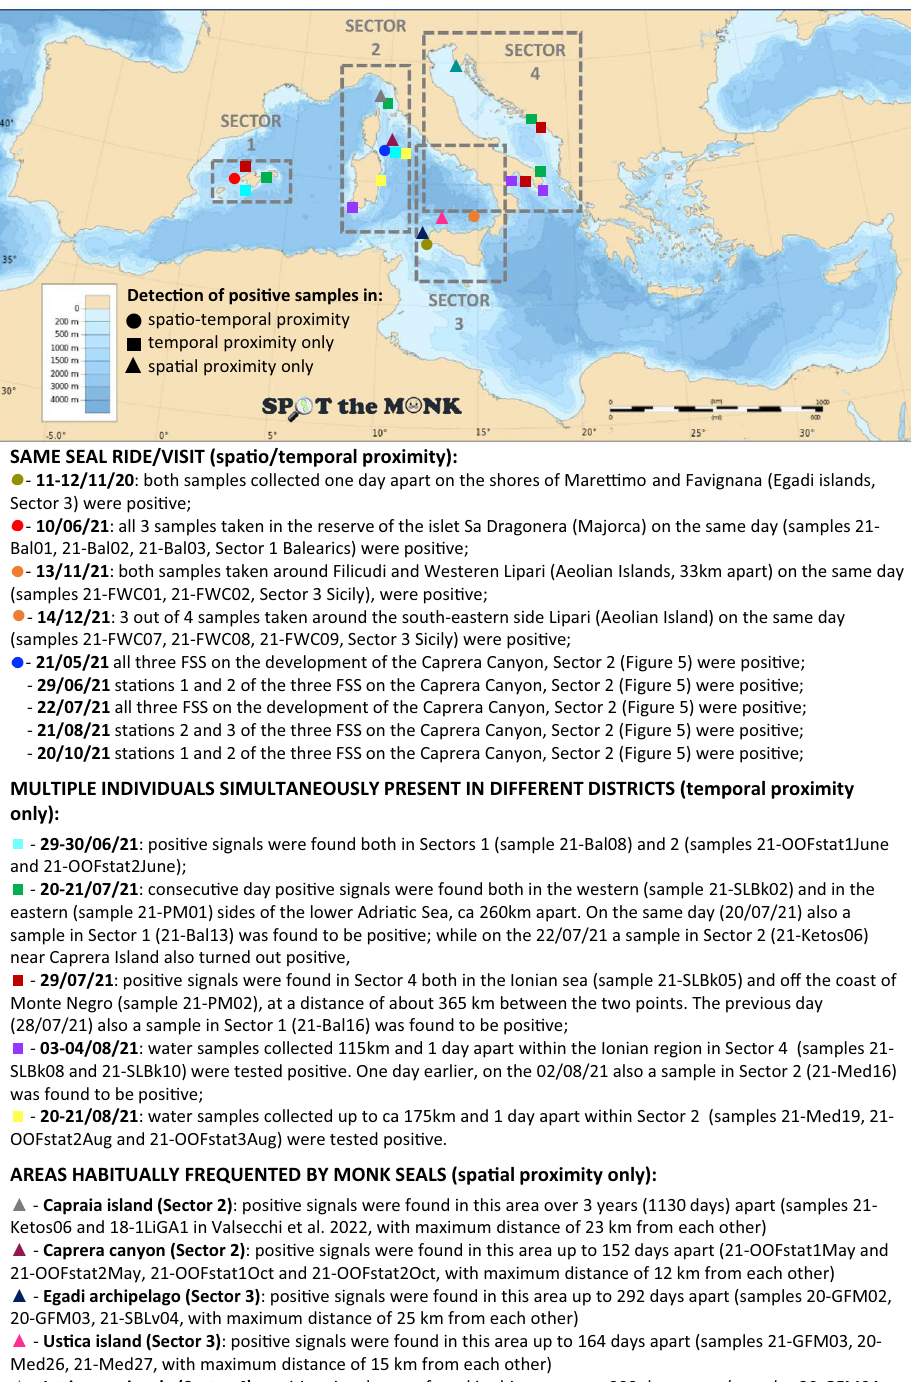
Figure 6. Results’ summary of the analysis of spatial/temporal distances between pairs of positive samples (refer to matrices in Supplementary Fig. 2S). Symbols of the same shape and colours indicate the position of samples collected in either spatial (triangle), temporal (square) or spatio-temporal (circle) proximity. The Mediterranean Sea Bathymetry map was retrieved from https:// commo ns. wikim edia.